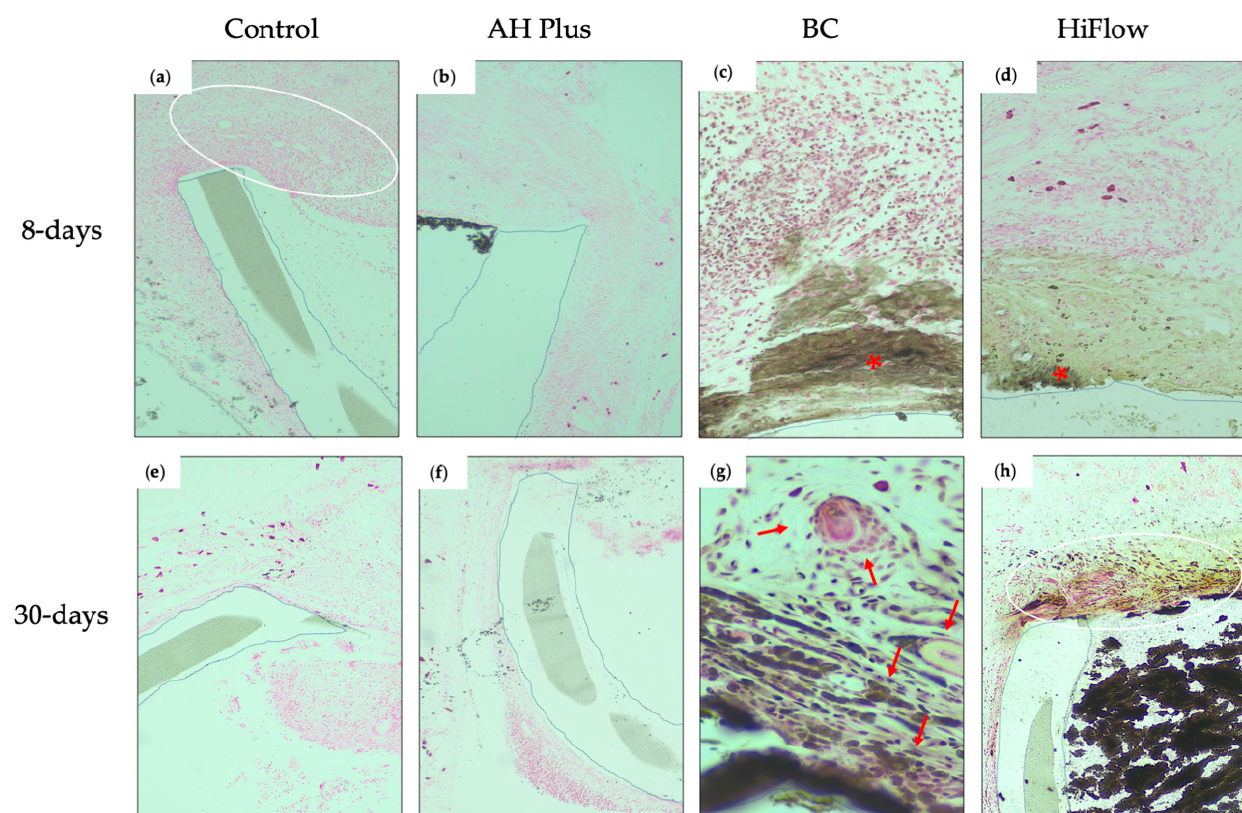
Figure 3. Histological images of the interface tissue-sealer (polyethylene tube demarcation with dotted lines) 8 and 30 days after subcutaneous implantation (von Kossa staining, magnification 200×). Eight days: ( a ) control group, fibrous capsule with fibroblasts and some inflammatory cells (score 1) without mineralization (white oval); ( b ) AH Plus, absence of mineralization around material and next to the fibro-inflammatory capsule; ( c ) BC group, area of mineralization in the capsule (brownish area) and von Kossa positive structures (red asterisk) surrounded by lymphocytes and some neutrophils; ( d ) HiFlow group, fibrous area with mild mineralization (right brownish area) and von Kossa positive structures (red asterisk) in the fibro-inflammatory capsule. Thirty days: ( e ) control group, absence of mineralization; ( f ) AH Pus, thin fibrous capsule without mineralization; ( g ) BC group, birefringent material and mild mineralization in between fibroblasts and surrounded by some inflammatory cells such as lymphocytes, plasma cells, rare neutrophils, and edema (red arrow); ( h ) HiFlow group, moderate mineralization (brownish aspect) in the thin fibrous capsule (white circle) and the sealer (black) inside the polyethylene tube. ( n = 8 for 8 days; n = 8 for 30 days).